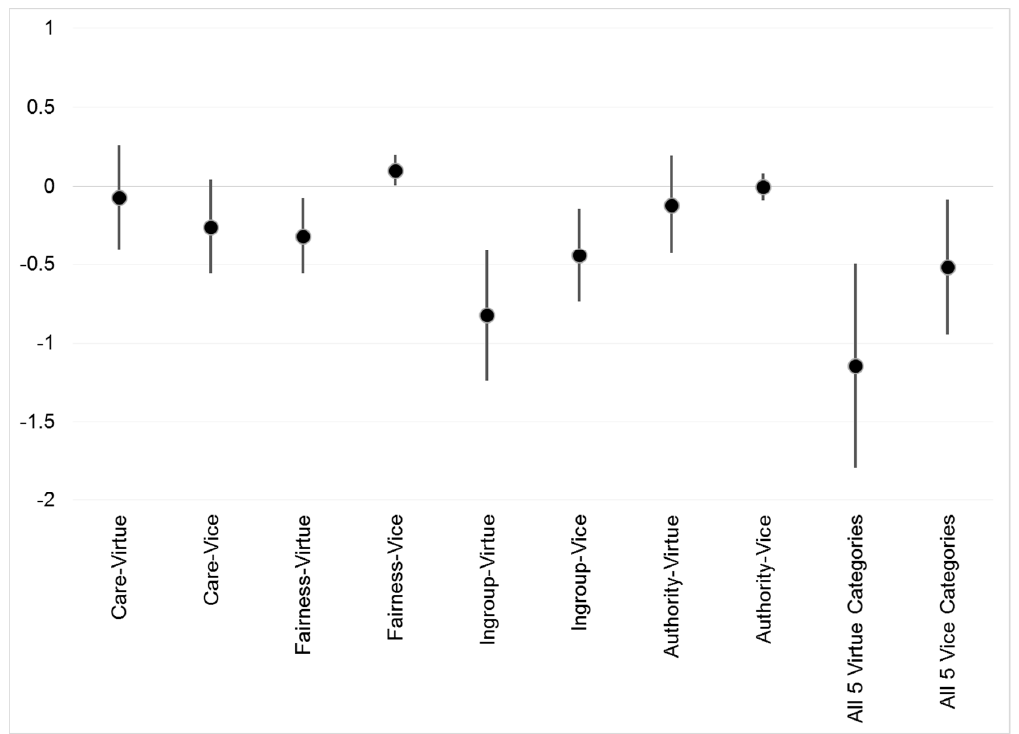
Figure 4. The estimated marginal effect of Donald Trump as speaker (relative to non-Trump Republican candidates) on the number of moral-foundations words used per segment. Dot represents point estimate and bar represents 95% confidence interval. The All 5 Virtue and All 5 Vice categories sum together the counts for all five moral foundations, including Purity.